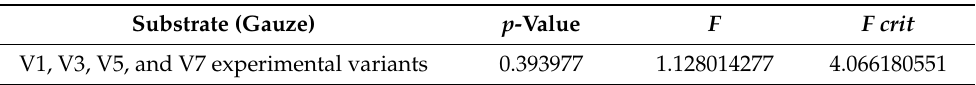
Table 5. A one-way ANOVA test for the antioxidant activity in Lepidium sativum L. sprouts. Substrate (Gauze) p -Value F F crit V1, V3, V5, and V7 experimental